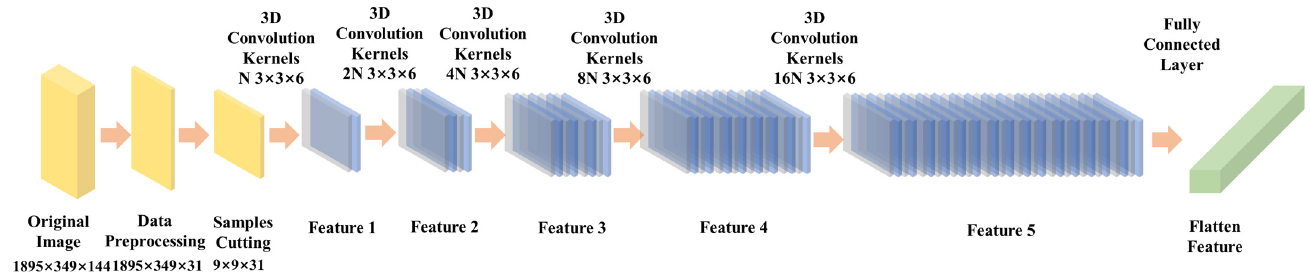
Figure 4. 3D-CNN architecture diagram.